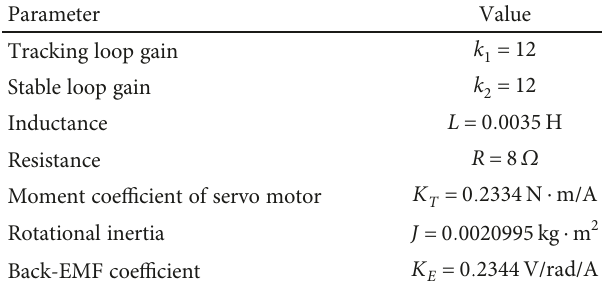
Table 1: Typical parameters of a platform